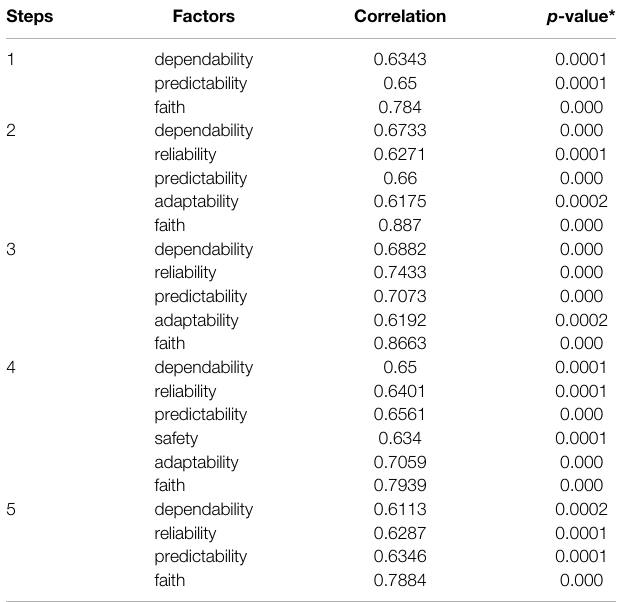
TABLE 4 | Factors strongly correlated with trust in dissipation phase over the fi ve steps ( r s (cid:1) 0 . 6 , α (cid:1) 0 . 05). No consistent correlation has been detected. Steps